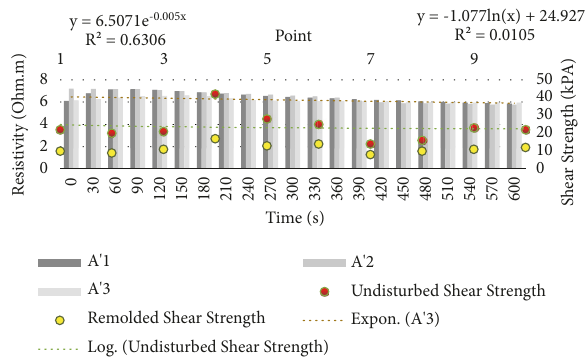
Figure 10: Line 3, in-situ